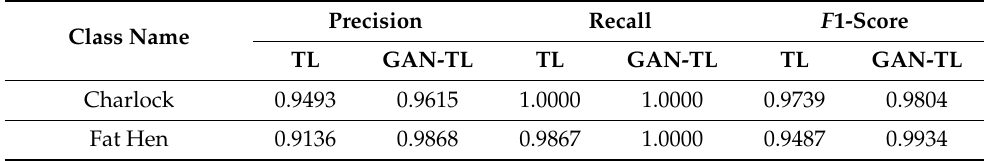
Table 3. Analysis of the classification results based on the transfer learning method. TL and GAN- TL refer to the models trained with the real image data, and combined real and artificial datasets,